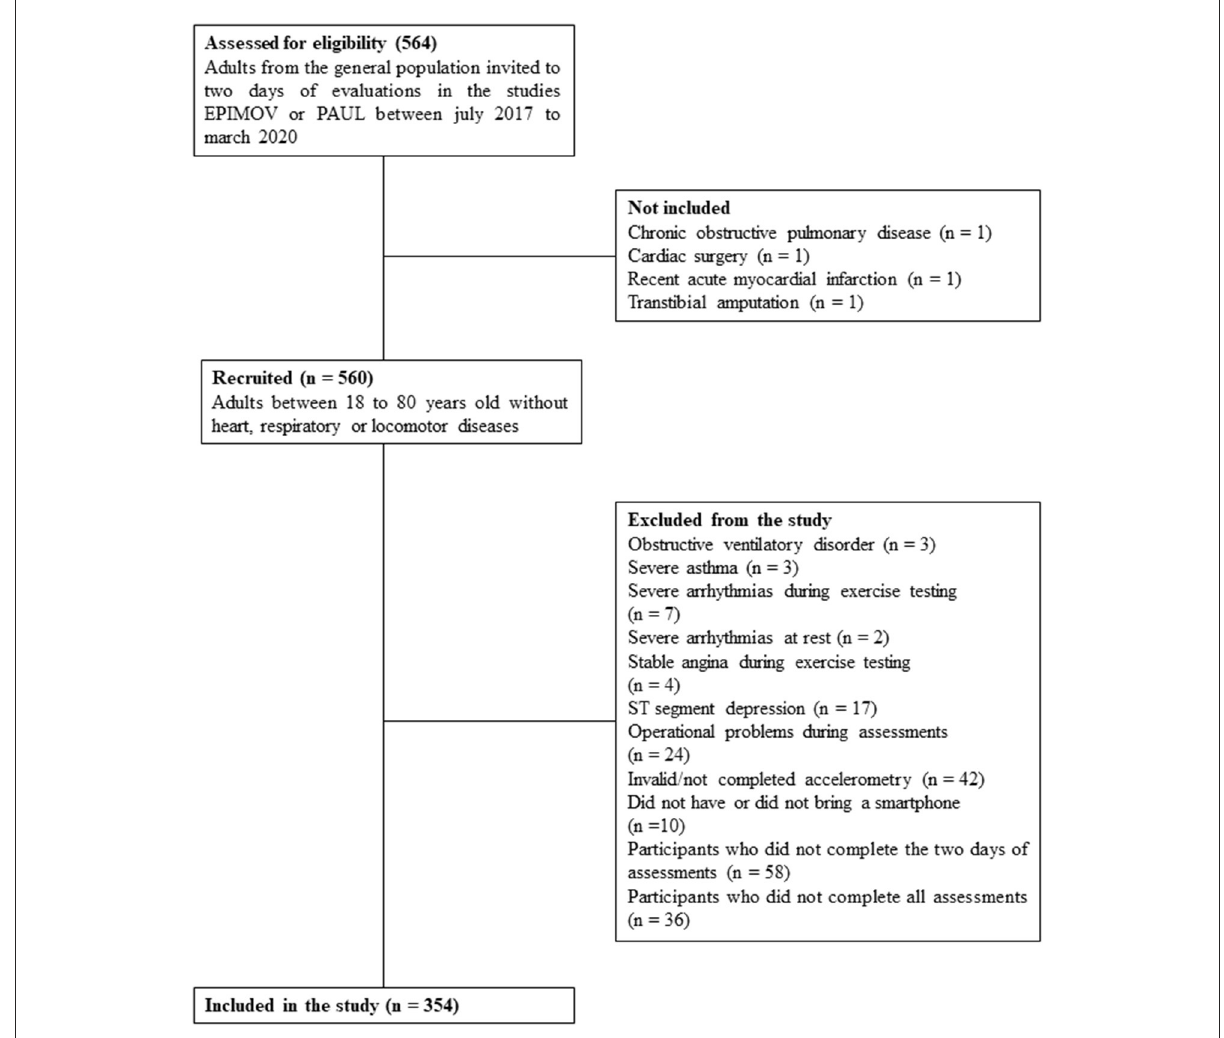
FIGURE1 Flowchart describing the steps of inclusion and exclusion of study